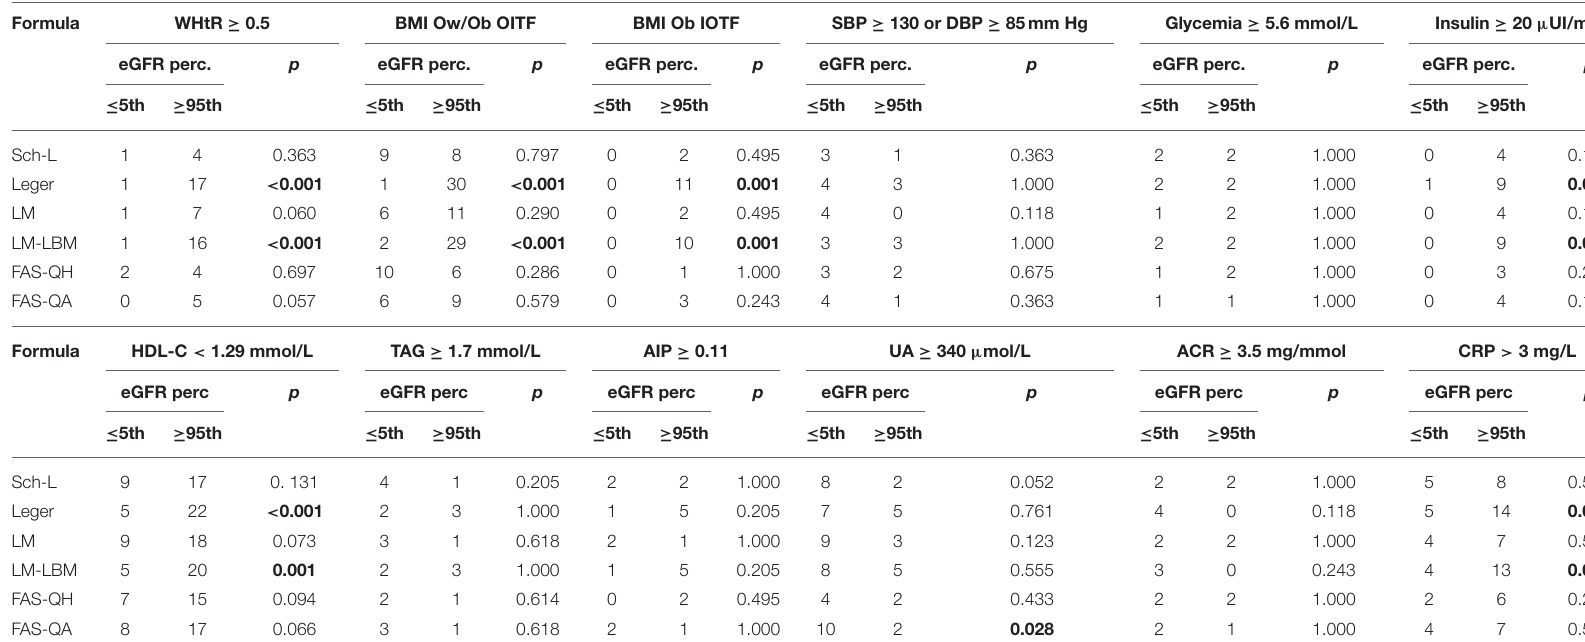
TABLE 7 | The prevalence of cardiometabolic risk factors in females with estimated glomerular filtration rate ≤ 5th vs. that of ≥ 95th according to six creatinine-based